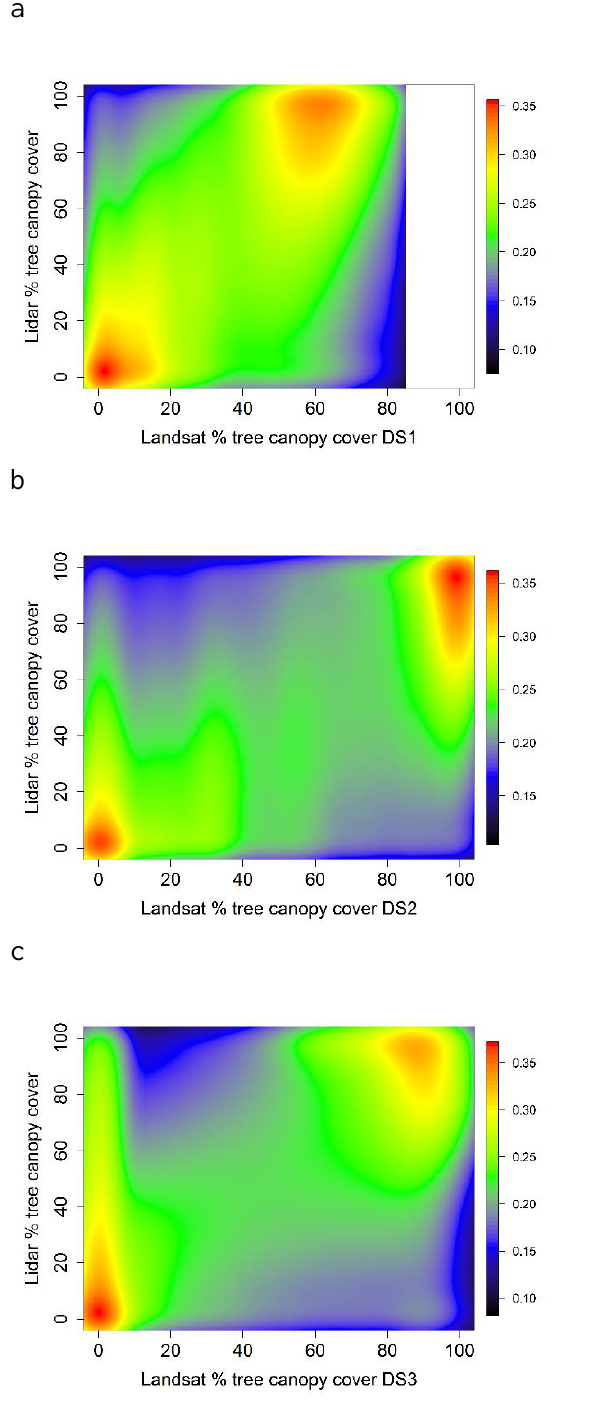
Figure 4. Scatter plots of Landsat-based percent tree canopy cover against Lidar reference. a. DS1 (Sexton et al. 2013). b. DS2 (Hansen et al. 2013). c. DS3 (Homer et al. 2004). Colours in the legends indicate scatter density.